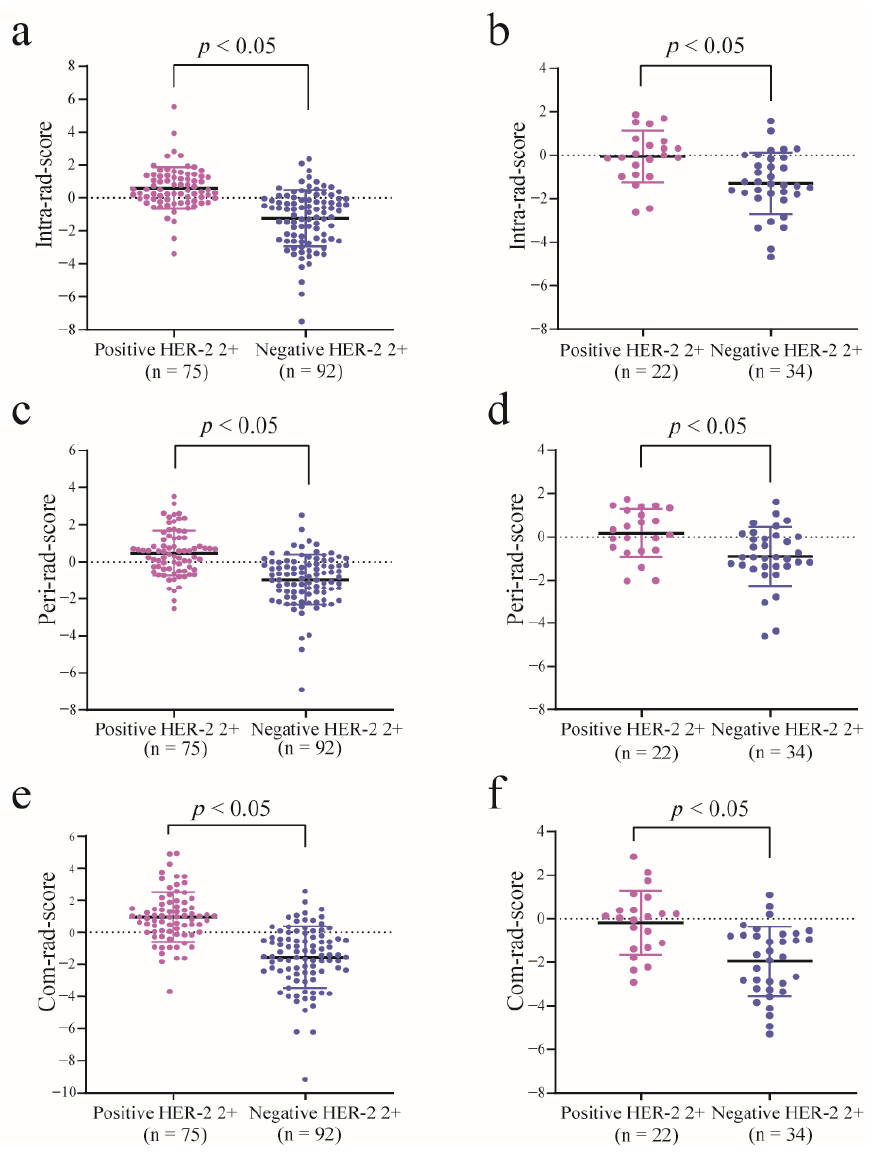
Figure 3. Dot diagram of the three rad-scores in the training (positive: n = 75, negative: n = 92) and validation (positive: n = 22, negative: n = 34) cohorts. Dot diagram of the intra-rad-score in the training ( a ) and validation ( b ) cohorts. Dot diagram of the peri-rad-score in the training ( c ) and validation ( d ) cohorts. Dot diagram of the com-rad-score in the training ( e ) and validation ( f ) cohorts.